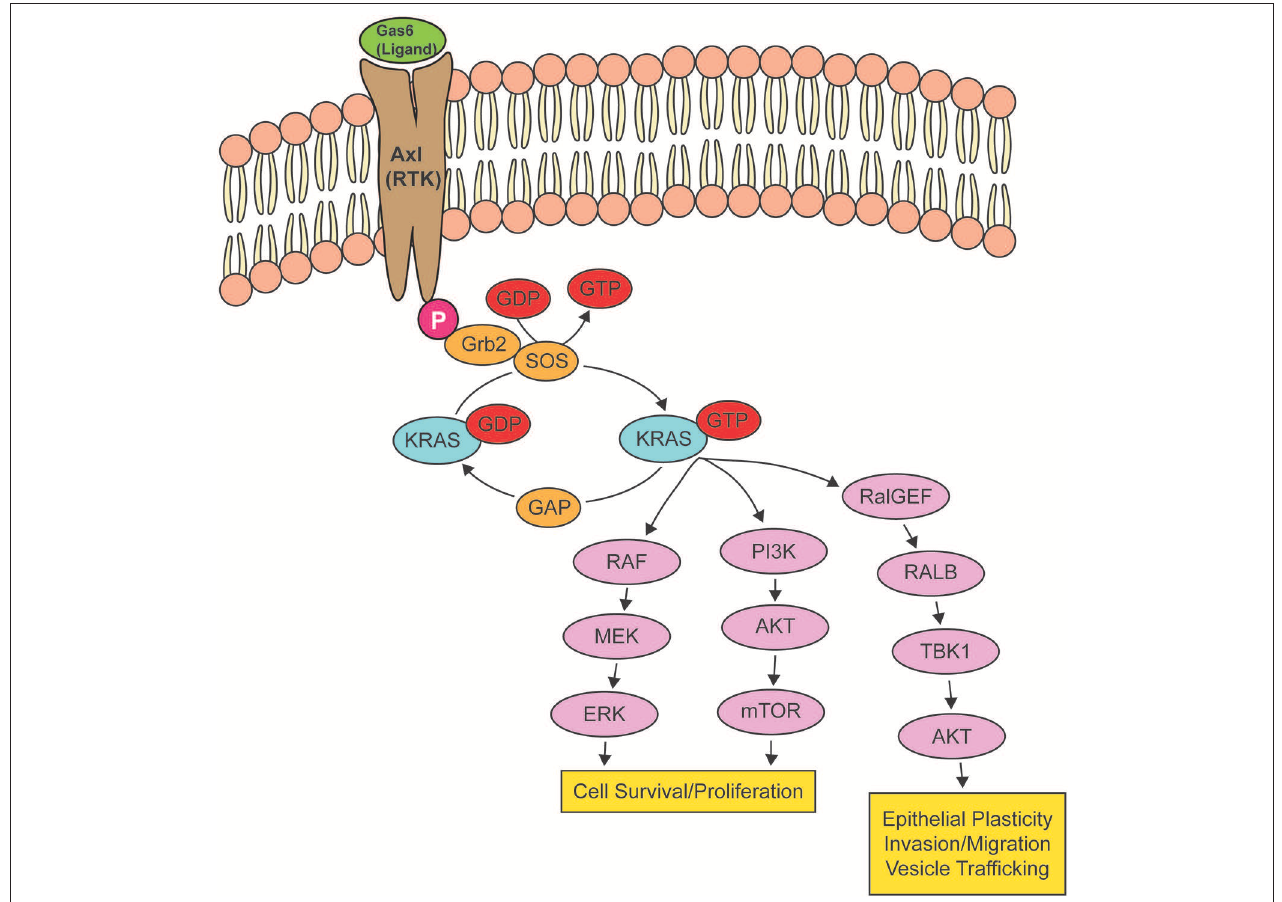
FIGURE 2 | Oncogenic KRAS effector pathways. When a receptor tyrosine kinase (RTK) is activated by its ligand, KRAS binds to GTP, rendering it active until the GTP hydrolyzes to GDP, turning KRAS off. When KRAS is mutated, KRAS remains bound to GTP, leading to the overstimulation of KRAS signaling pathways, resulting in cell survival and proliferation, epithelial plasticity, and migration. The activation of RTK AXL by GAS6 is shown as a potential signaling pathway that can drive an epithelial-to-mesenchymal transition via the activation of